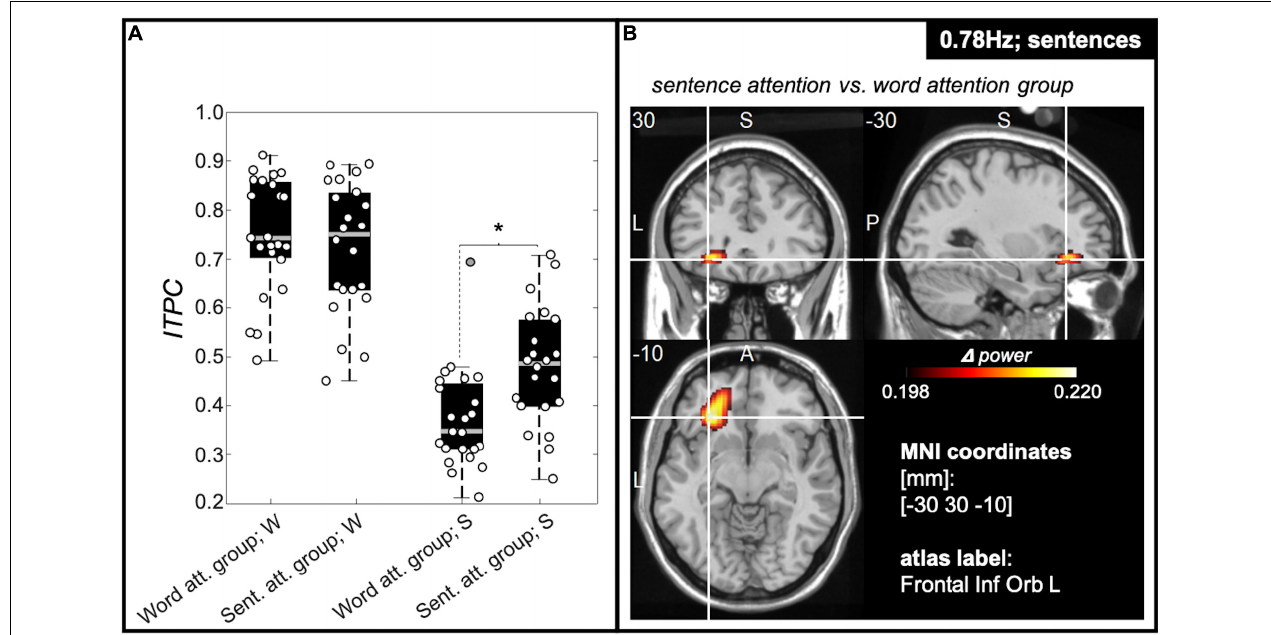
FIGURE 5 | ITPC values at sentence frequency are modulated by attention. (A) Box plots representing ITPC values at word- (“W”) and sentence (“S”) frequency for participants of the word group and the sentence group averaged over the 5% of electrodes with the highest ITPC values. We observed a significant interaction between tracking frequency [words (3.125 Hz) and sentences (0.78 Hz)] and attention condition [attention to words (word group), attention to sentences (sentence group)] [ F (1,91) = 5.92; p = 0.017]. Post hoc t -tests revealed a significant effect of attention on tracking strength for the sentence rate tracking only, showing significantly stronger ITPC values for the sentence group compared with the word group (see right part of A) . Tracking strength at the word rate, however, was comparable between the participant groups (left part of A ). The central gray lines mark the median, and the bottom and top edges the 25th and 75th percentiles of the data, respectively. Error bars extend to the extreme values, excluding outliers, and circles show data of the individual participants. Filled gray circles represent outliers. (B) Source estimation of difference in power at sentence frequency between sentence and word group in functional ortho-plots (functional values are thresholded to present only the top 10% virtual electrodes). The peak region was identified as left inferior frontal gyrus. (Letters indicate anatomical landmarks; A = anterior, P = Posterior, L = left, S = superior; numbers indicate location of crosshair in the brain in